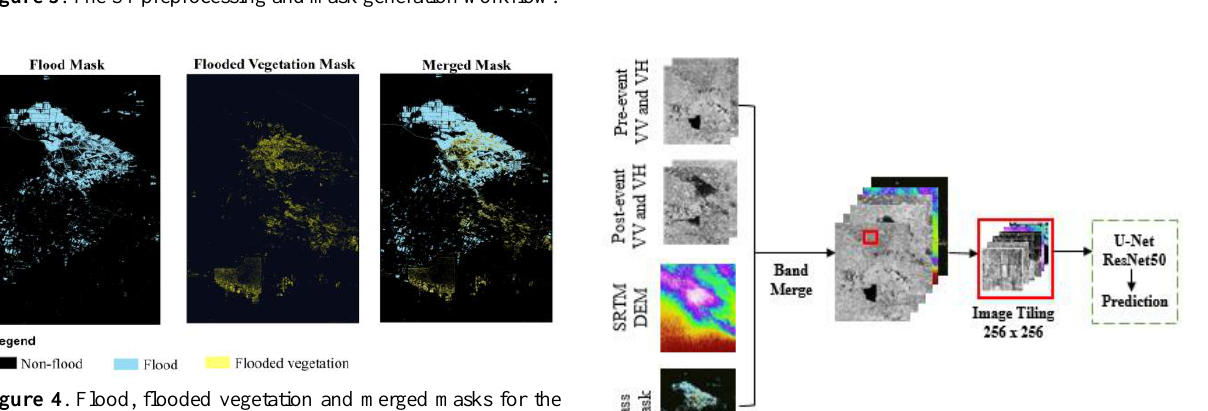
Figure 3 . The S1 preprocessing and mask generation workflow.